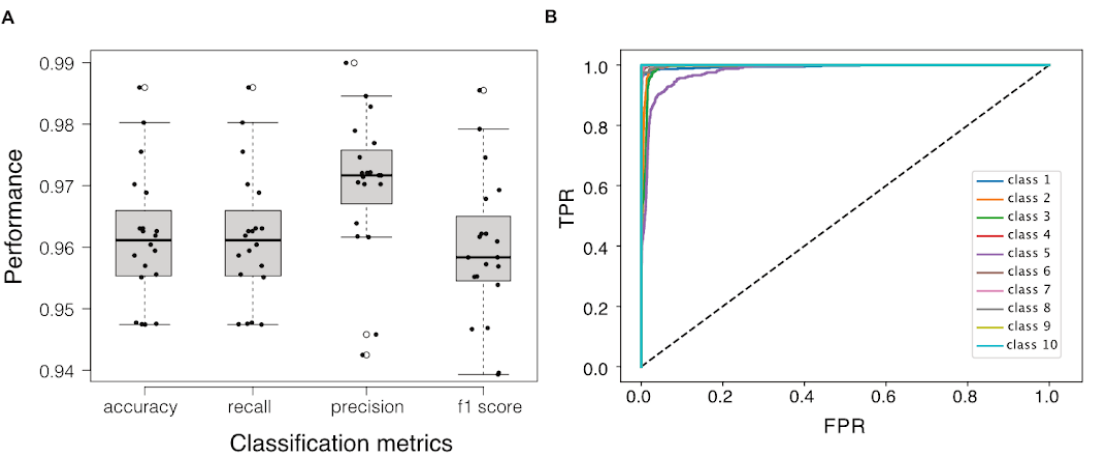
Figure 4. Class prediction performance with reduced features selected by RGIFE+RF model. ( A ) Boxplot of model performances in terms of accuracy, recall, precision and f1 score. ( B ) Receiver operating characteristic curves that reveal the relationship between true positive rate and false positive rate at various thresholds for predicting 10 classes, respectively.